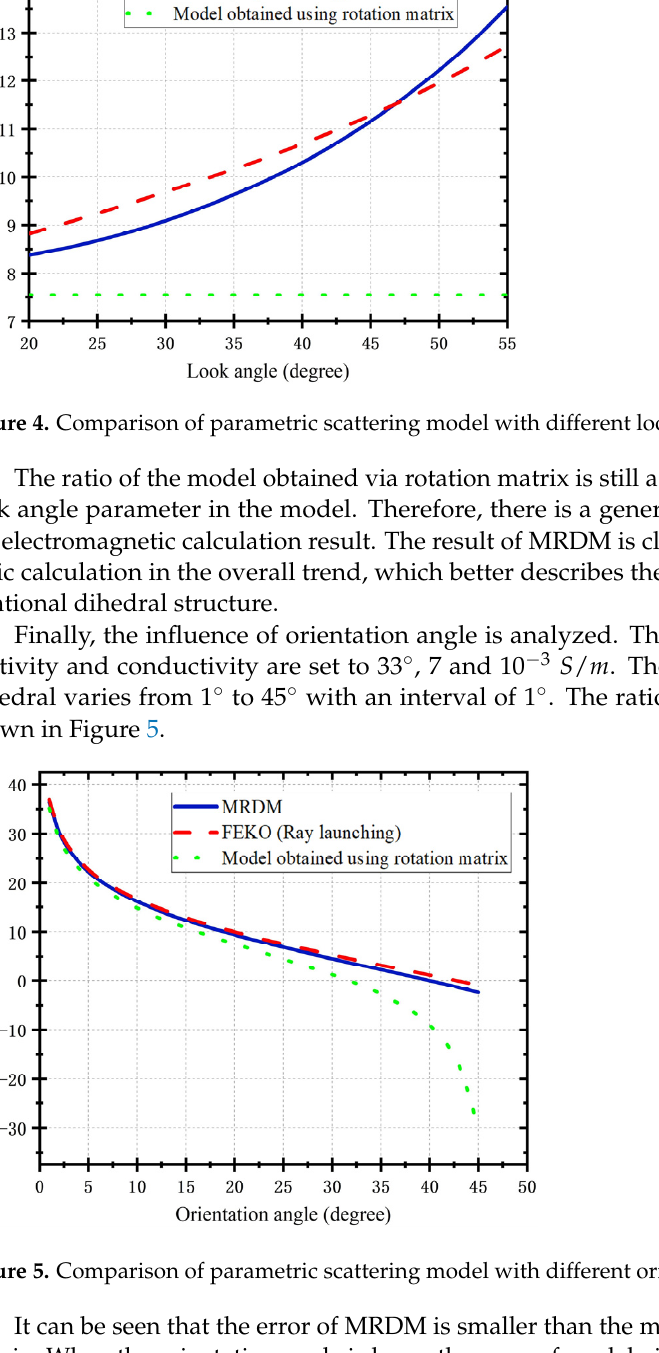
7 of 27 Figure 2. Comparison of parametric scattering model with different relative permittivities. Figure 3. Comparison of parametric scattering model with different conductivities. When the relative permittivity is small, the ratios of MRDM have some error com- pared to the electromagnetic calculation results obtained via FEKO. As the relative per- mittivity increases, the error decreases gradually. It is worth noting that the ratio of the dihedral model obtained via rotation matrix is constant. It indicates an obvious error in comparison to the electromagnetic calculation result. The results under different conduc- tivities show that there are some errors between MRDM and FEKO results when the con- ductivities are small. When it becomes large, the error of MRDM is greatly reduced. How- ever, compared with the results obtained via rotation matrix, the precision of MRDM is